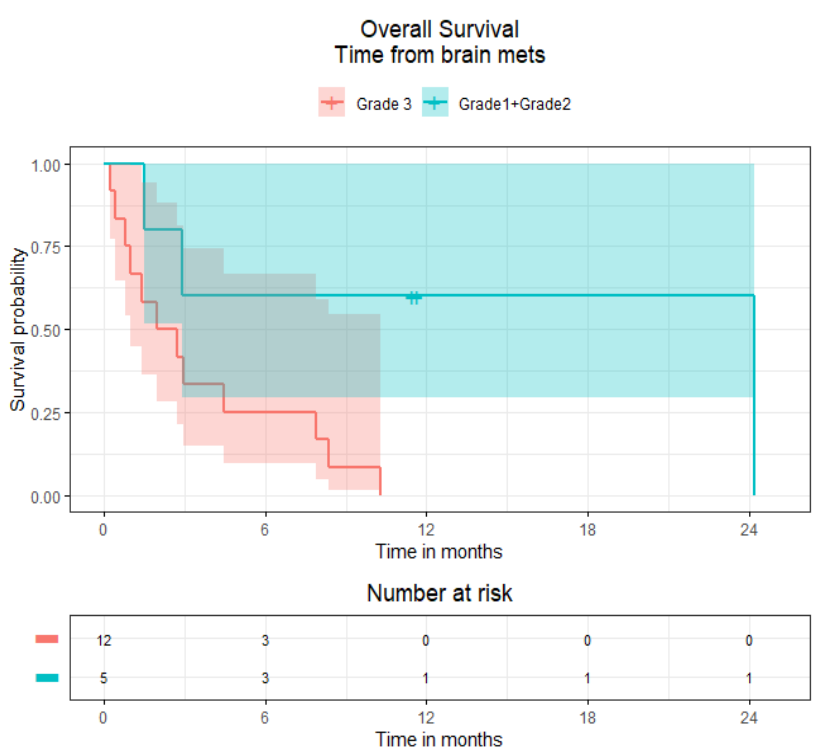
Figure 4. Kaplan–Meier overall survival curves of patients with advanced extra-pulmonary neuroen- Figure 4. Kaplan – Meier overall survival curves of patients with advanced extra-pulmonary neuro- docrine neoplasms without brain metastases by histological grades 1, 2, and 3. endocrine neoplasms without brain metastases by histological grades 1, 2, and 3.